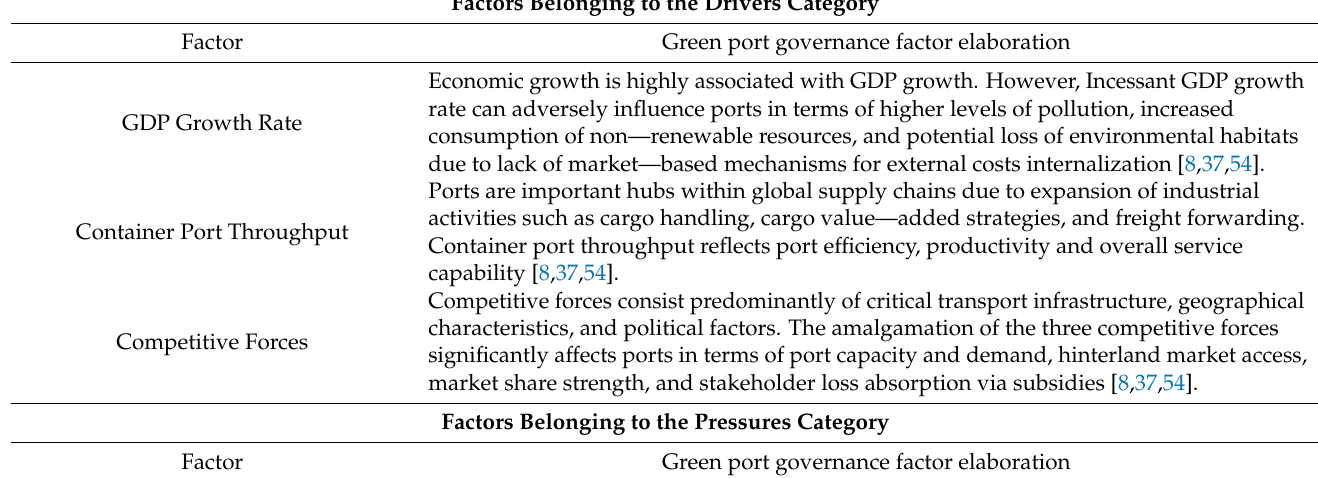
Table 7. Elaboration of the 16 pivotal factors influencing the establishment of green port gover- nance